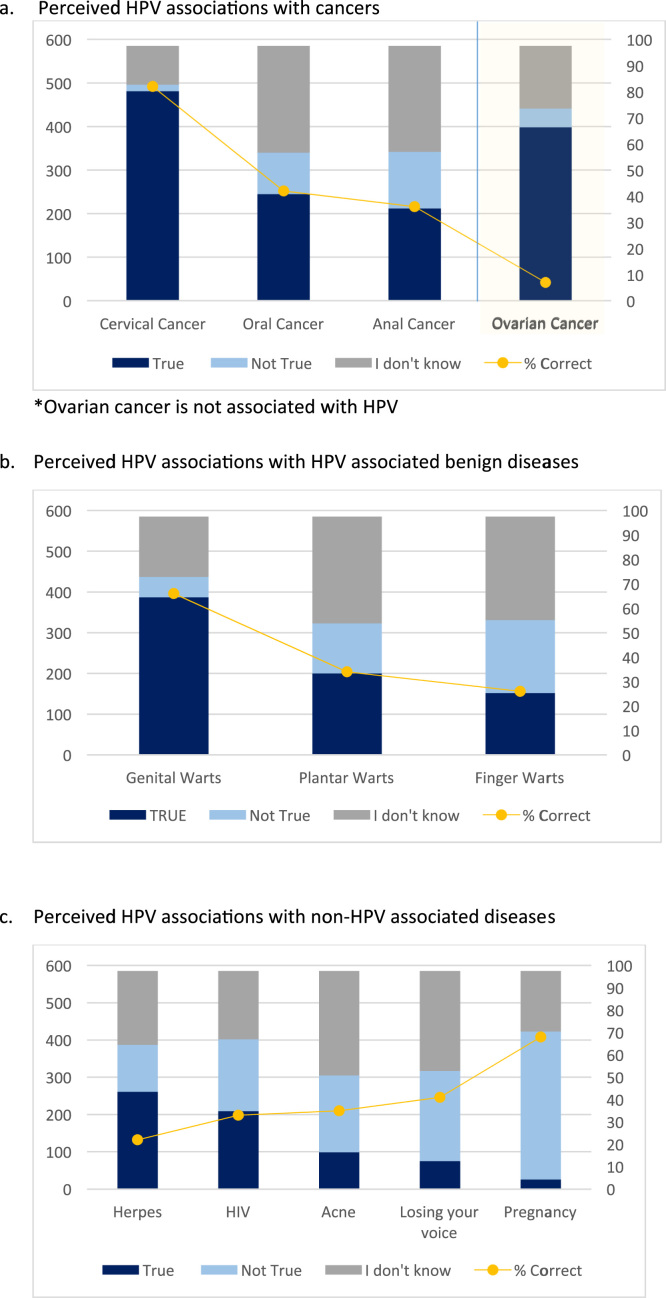
Perceived knowledge of HPV associated diseases. a) Perceived HPV associations with cancers. b) Perceived HPV associations with HPV associated benign diseases. c) Perceived HPV associations with non-HPV associated diseases.